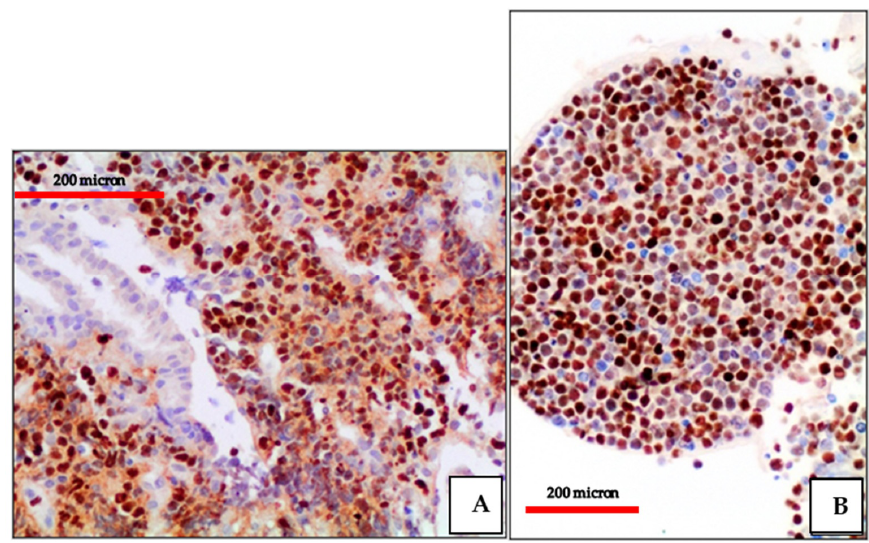
Figure 11. ( A ) BL of the duodenum: diffuse EBV expression by in situ hybridization (EBER-ISH, magnification 200 × ; original image from Prof Ascani); ( B ) BL of the duodenum: diffuse MYC protein overexpression of the lymphoid cells (immunostaining, Ventana immunostainer, magnification 200 × original image from Prof Ascani).